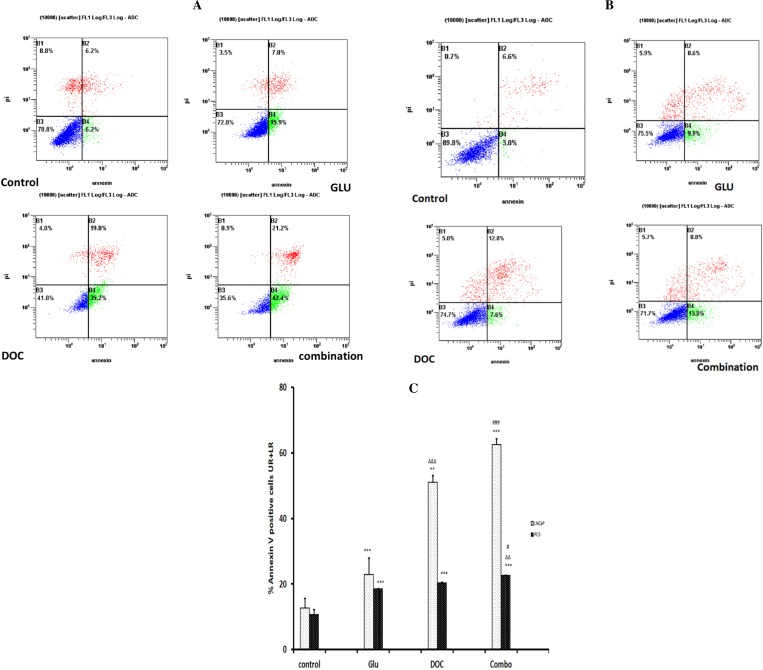
(A) AnnexinV-FITC apoptosis assay for LNCaP cells after treatment for 72 h.The experiment was done in triplicates and a representative figure was chosen for the dot plot. (B) AnnexinV-FITC apoptosis assay for PC-3 cells after treatment for 72 h the experiment was done in triplicates and a representative figure was chosen for the dot plot. (C) Effect of different treatments on the Annexin V-FITC Positive staining in PC-3 and LNCaP Cells. The experiment was done in triplicates. (∗∗∗) significantly different compared to the control at P < 0.001. (∗∗) significantly different compared to the control at P < 0.01.). (\documentclass[12pt]{minimal}
\usepackage{amsmath}
\usepackage{wasysym}
\usepackage{amsfonts}
\usepackage{amssymb}
\usepackage{amsbsy}
\usepackage{upgreek}
\usepackage{mathrsfs}
\setlength{\oddsidemargin}{-69pt}
\begin{document}
}{}$\mrm{\Delta }\mrm{\Delta }\mrm{\Delta }$\end{document}ΔΔΔ) significantly different compared to GLU at P < 0.001. (\documentclass[12pt]{minimal}
\usepackage{amsmath}
\usepackage{wasysym}
\usepackage{amsfonts}
\usepackage{amssymb}
\usepackage{amsbsy}
\usepackage{upgreek}
\usepackage{mathrsfs}
\setlength{\oddsidemargin}{-69pt}
\begin{document}
}{}$\mrm{\Delta }\mrm{\Delta }$\end{document}ΔΔ) significantly different compared to GLU at P < 0.01. (###) Significantly different than DOC at P < 0.001. (#) Significantly different than DOC at P < 0.05. Data are means ± SD (n = 3).